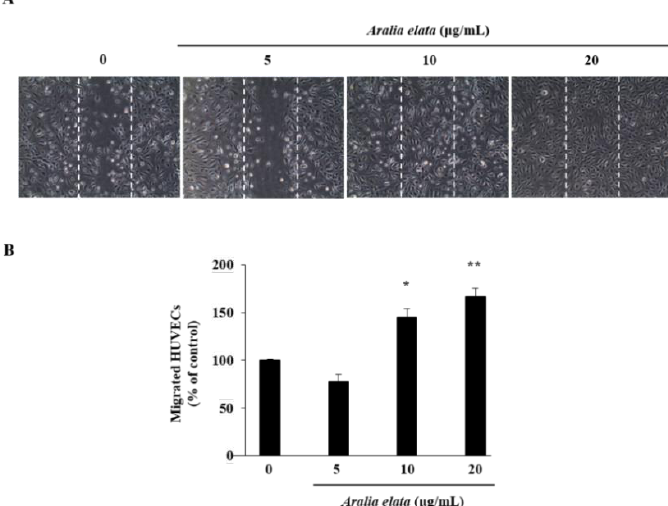
Figure 2. Effects of AS on HUVEC migration. Cells were grown to confluence in six-well plates, wounded, and treated with the indicated concentrations of AS. ( A ) Representative images show cell migration in control and AS-treated HUVECs. ( B ) Cell migration expressed as a percentage of that observed in control cells. Data represent the mean ± SD. * p < 0.05, ** p < 0.01.